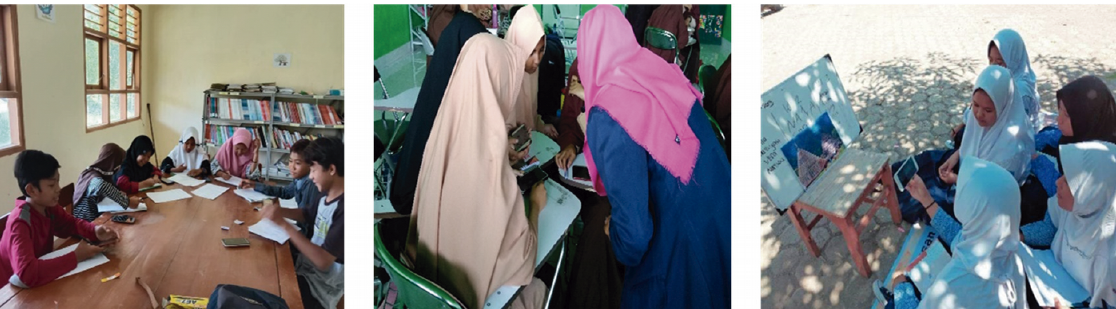
Figure 5. Learning